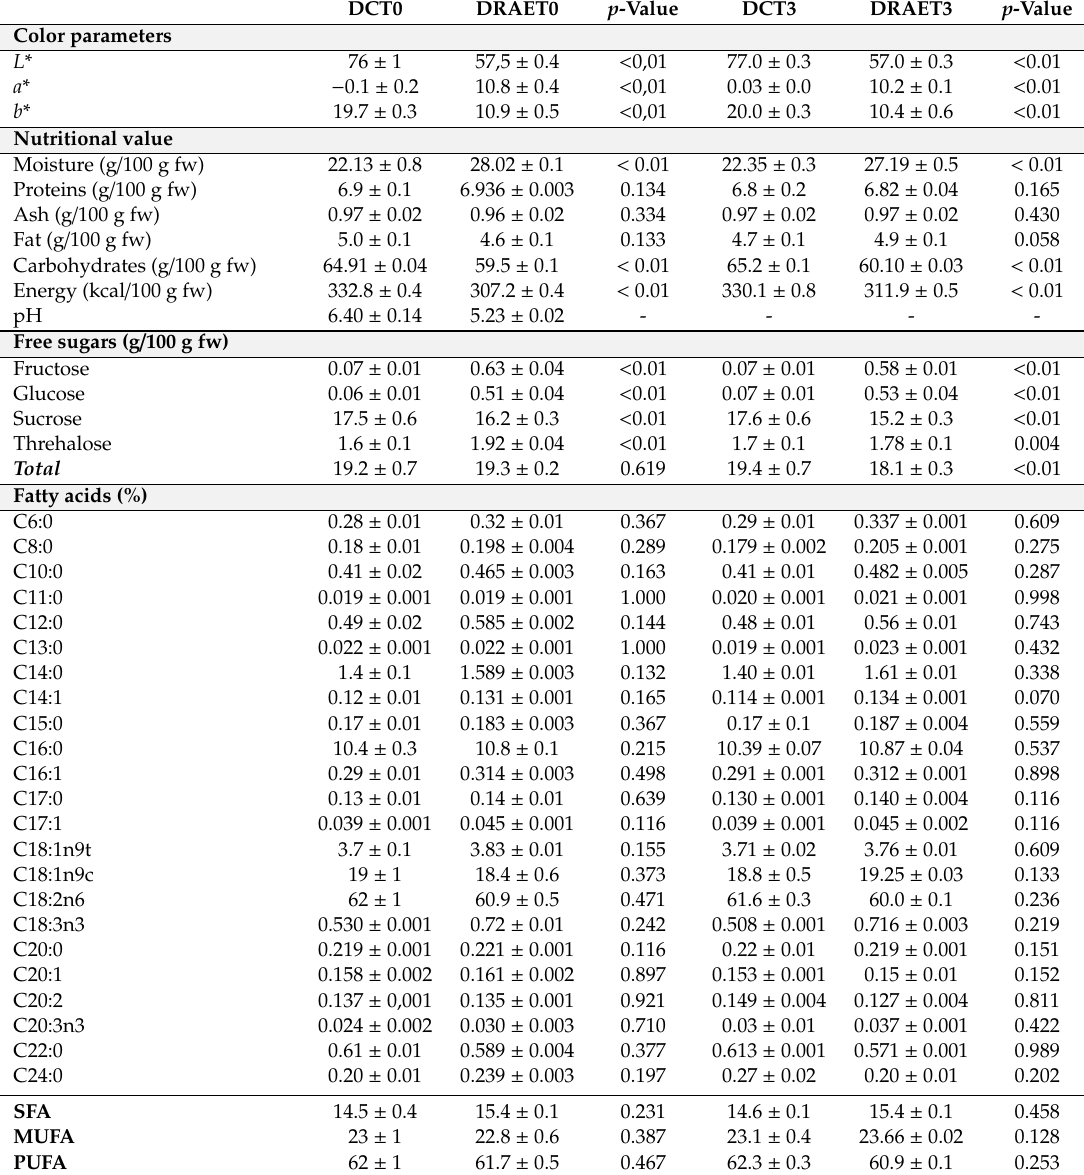
Table 5. Color parameters (CIE L *, a *, b *), nutritional value, free sugars (g / 100 g fw) and fatty acids (%) composition of the donut samples during storage time (T0 and T3